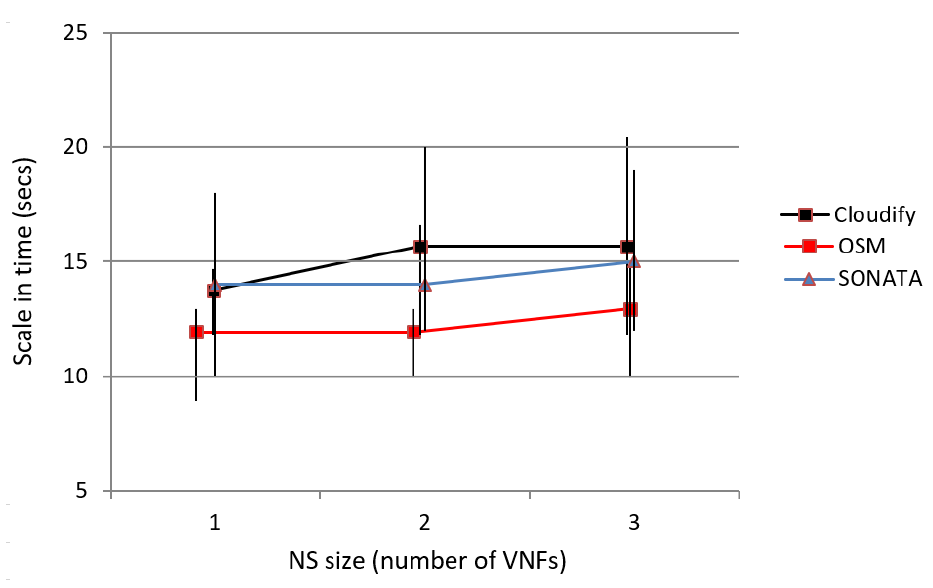
Figure 6. Average scaling-in